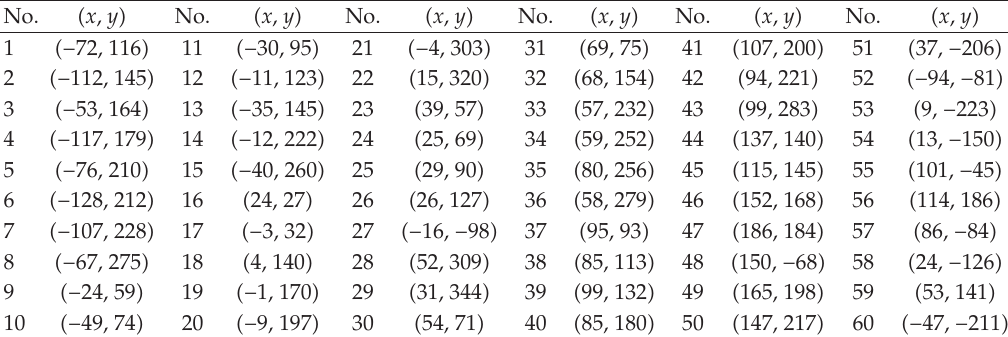
Table 4: Coordinates of the points in Q under translation and rotation